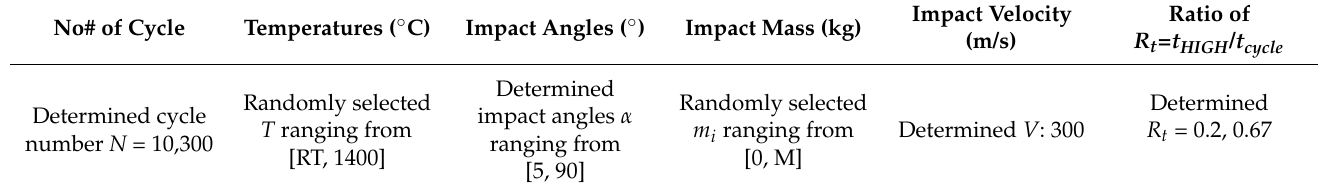
Table 11. Parameters used to calculate erosion rates versus impact angles at selected high-temperature dwell period and thermal cycles.